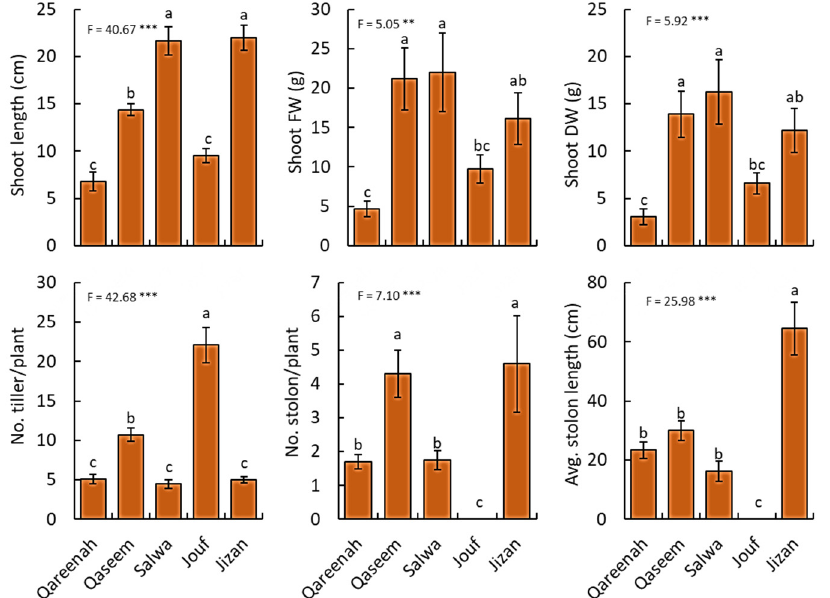
Figure 2. Comparison of shoot traits of Aeluropus lagopoides growing in different saline flat regions of Saudi Arabia. Values are average ( n = 75 ), and the bar represents the standard error. Different letters among regions showed significant differences at p < 0.05 after Duncan’s test. ** p < 0.01*** p < 0.001.